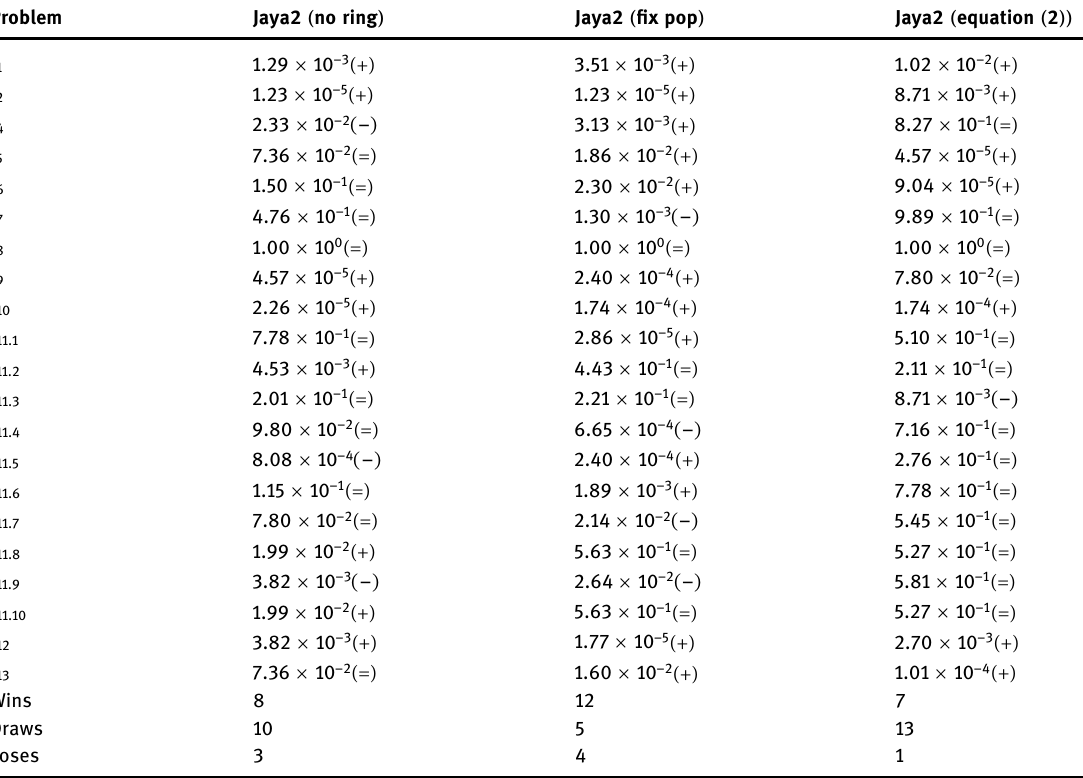
Table 21: The CEC 2011 statistical analysis showing the Wilcoxon test p - value Problem Jaya2 ( no ring